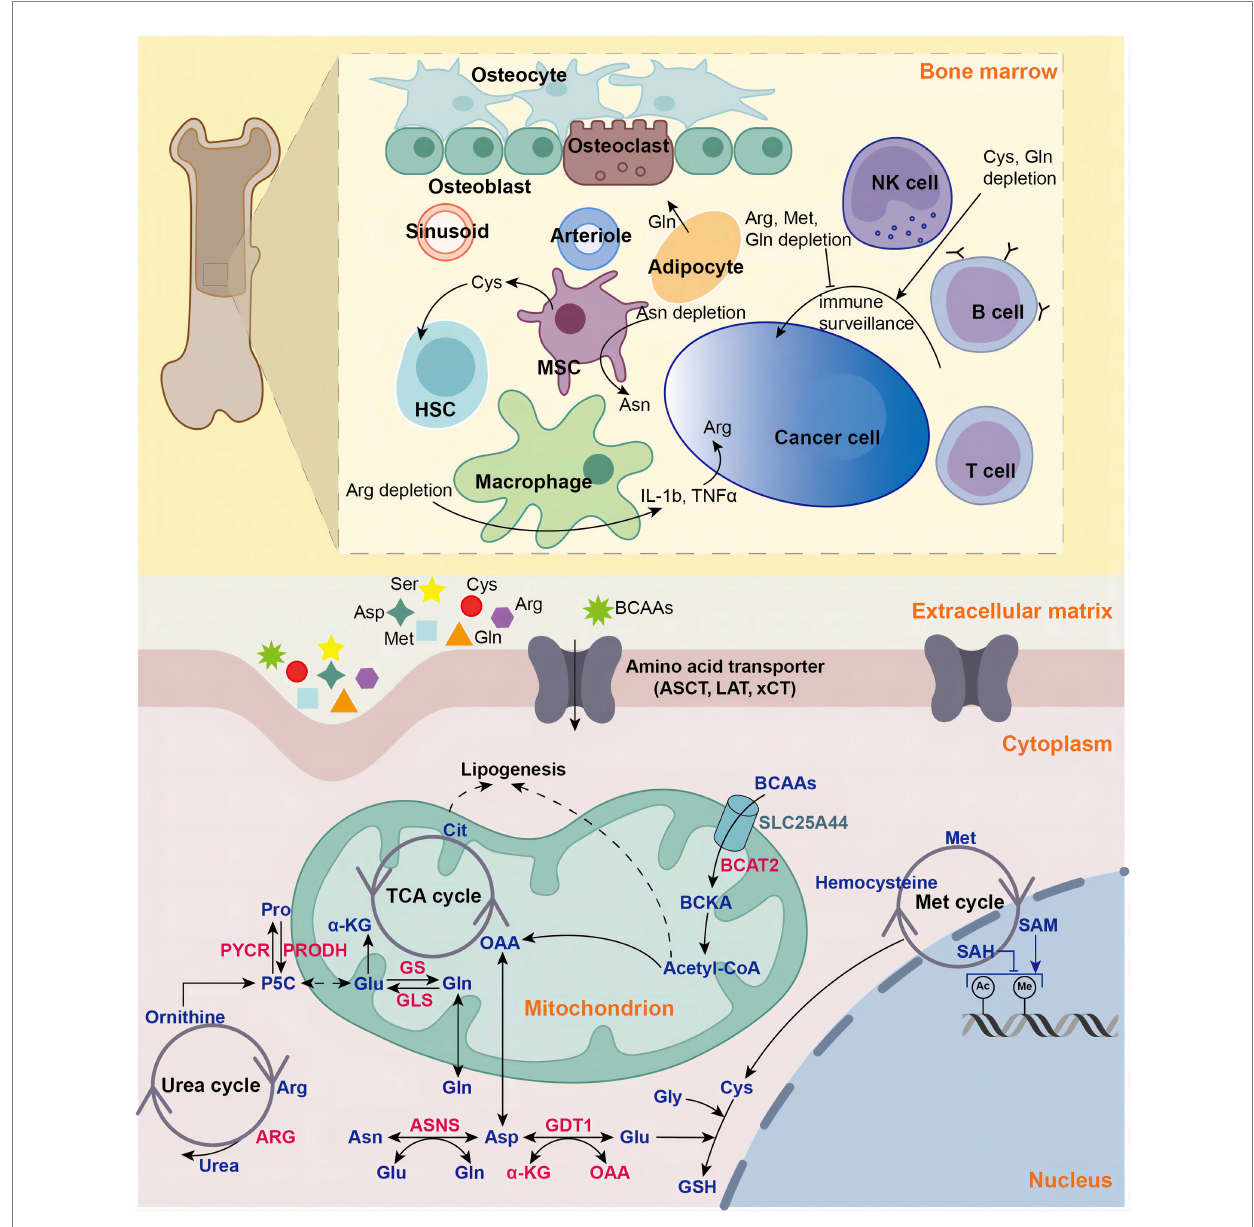
FIGURE 1 Amino acids in hematologic malignancies. Amino acids play vital roles in in tumorigenesis and development in hematologic malignancies, including energy supply, biosynthetic support, redox balance maintenance, epigenetic regulation and tumor microenvironment modulation. NK natural